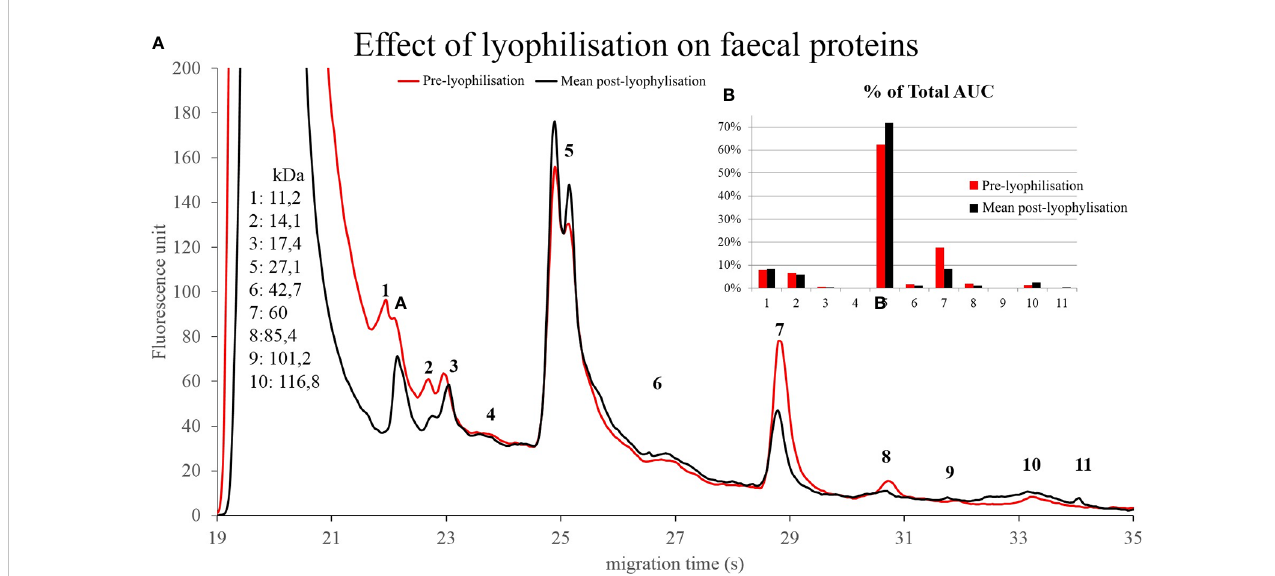
FIGURE 11 Protein compositions of donor stool before (red) and after (black) lyophilisation (A) . The numbered data points refer to different components. The molecular weights of the components can be seen on the left side in kilodaltons. The bar graph on the right side (B) compares the relative abundance of the components in the pre-lyophilisation and the post-lyophilisation